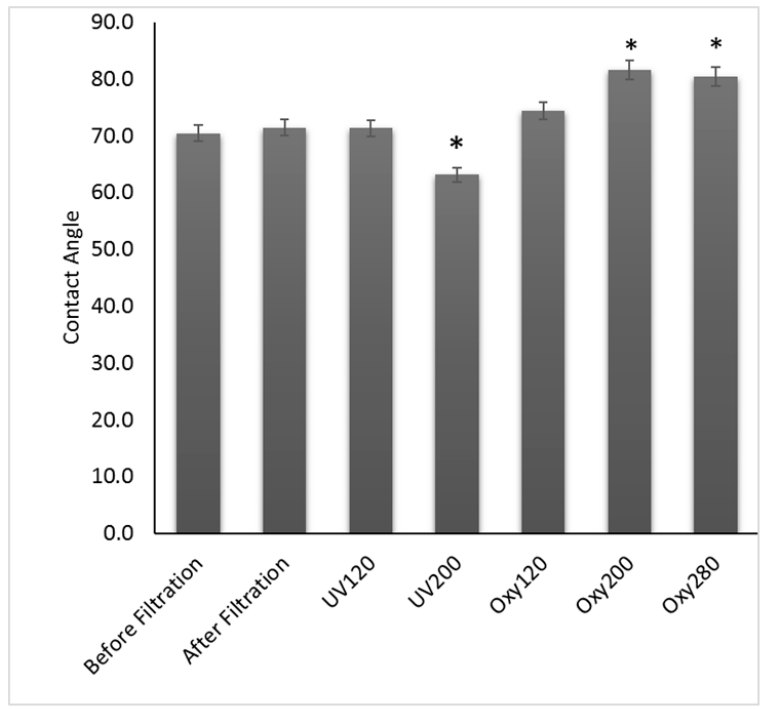
Figure 3. Water interaction parameter graph, to represent different levels of hydrophobicity, for different membrane surface treatment techniques studied. The significant differences in contact angle between treatments with no treatment-alternative is indicated with * at p < 0.05.